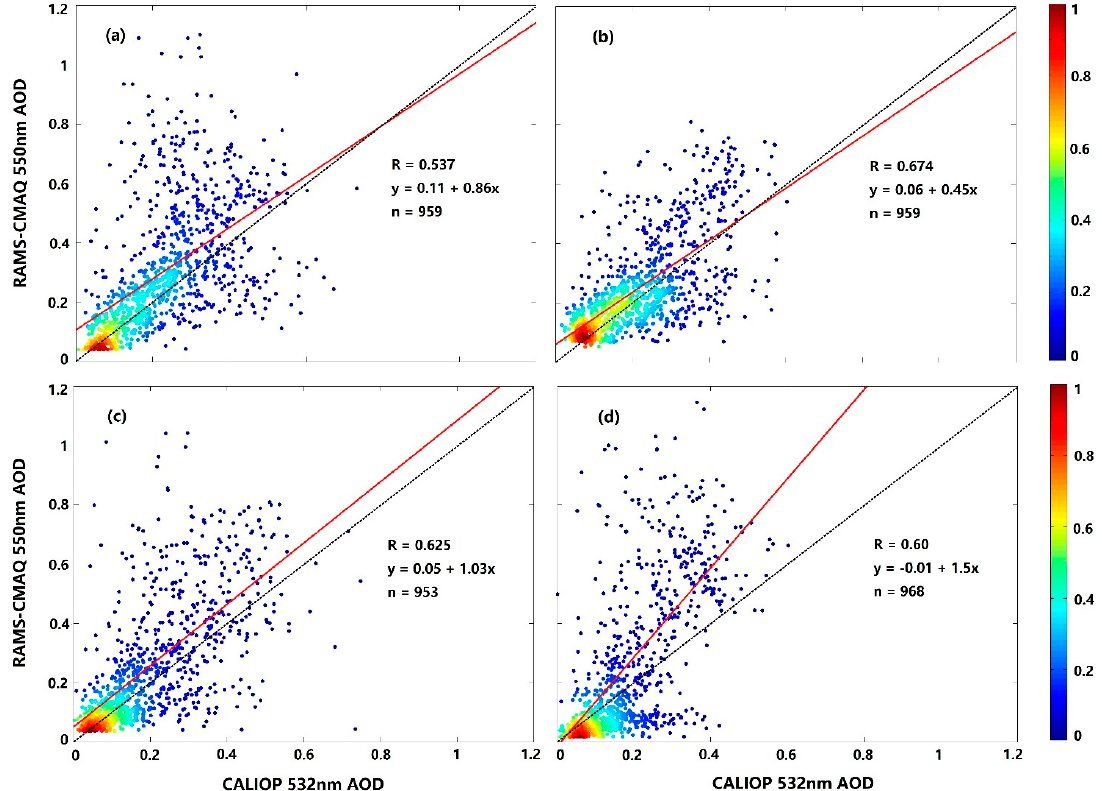
Figure 4. Comparison of the seasonal CALIOP-retrieved AOD data with the RAMS-CMAQ-simulated AOD for ( a ) spring (MAM); ( b ) summer (JJA); ( c ) fall (SON); and ( d ) winter (DJF), respectively.